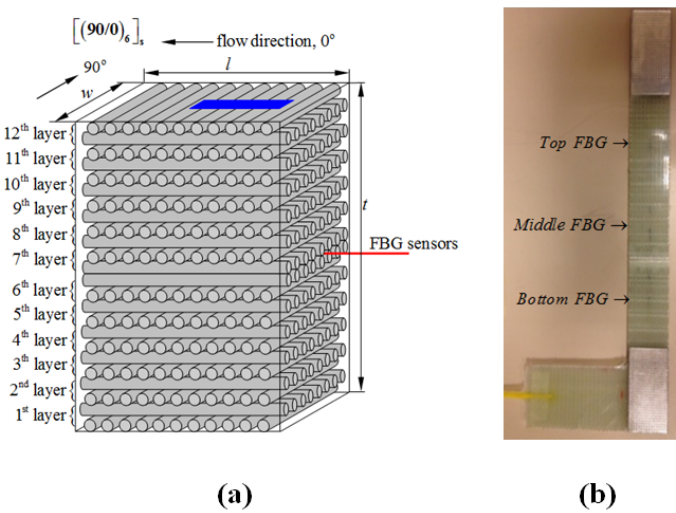
Figure 1. ( a ) The schematic drawing for stacking sequences together with the placement of FBG sensors and also the orientation of the cut test specimen indicated by the blue region where l , w and t indicate the length, width and the thickness of the manufactured composite plate; ( b ) L-shaped specimen that enables easy gripping of the test specimen by the testing